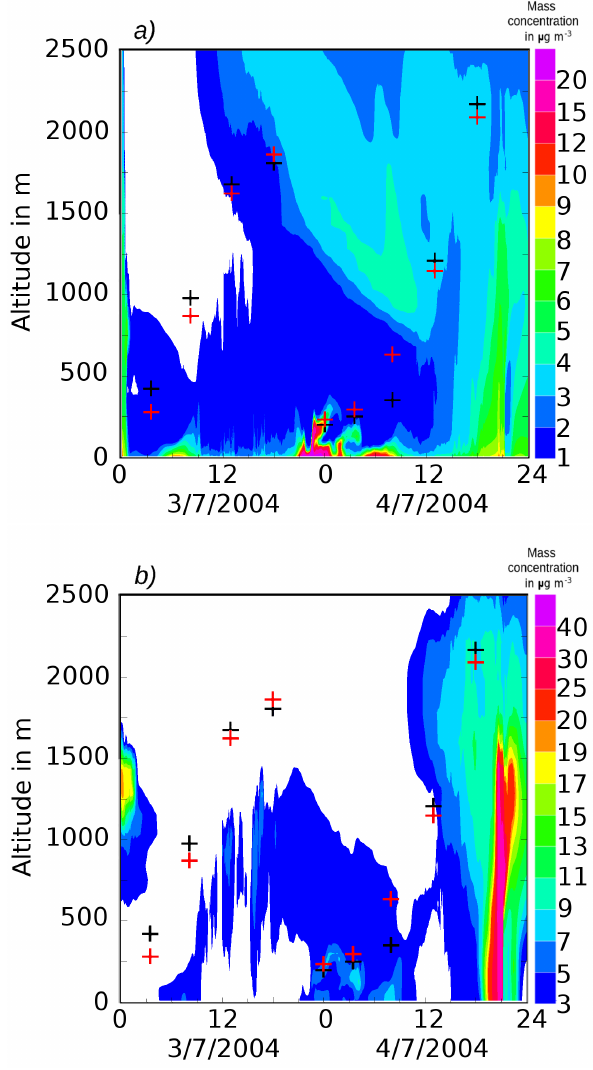
Fig. 7. Primary (a) and secondary (b) aerosol mass concentration profiles modeled during the 48 hours of simulation at the location of the downtown site grid point. The obsever (black crosses) and modeled (red crosses) boundary layer height are shown.